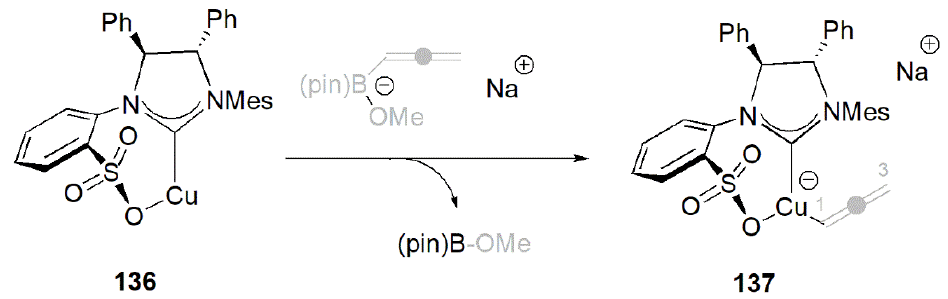
Figure 14. Different reactivity of organometallic reagents [102].